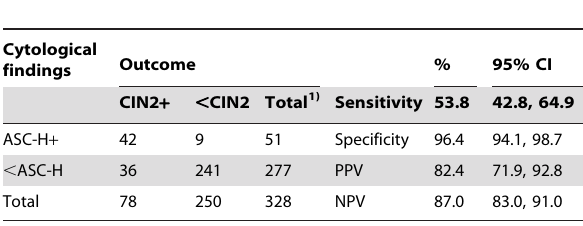
Table 3. Outcome for the 328 women in the cytology only group if triaged with post-colposcopy cytology when cut-off is ASC-H + .